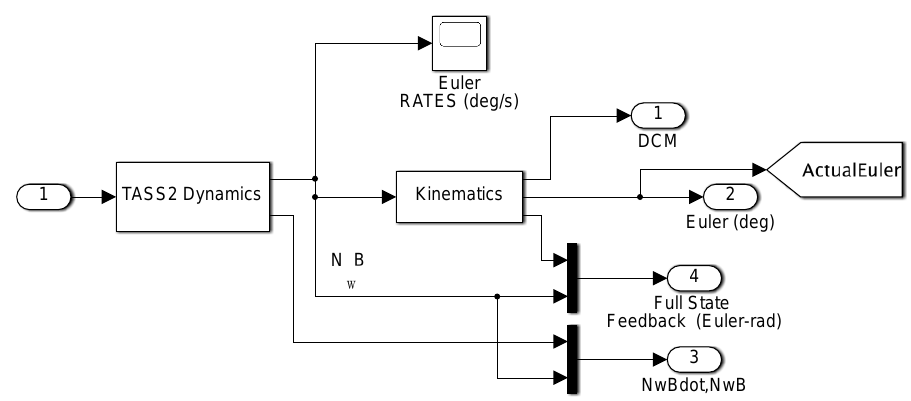
Figure A8. Rigid body Dynamics block model.